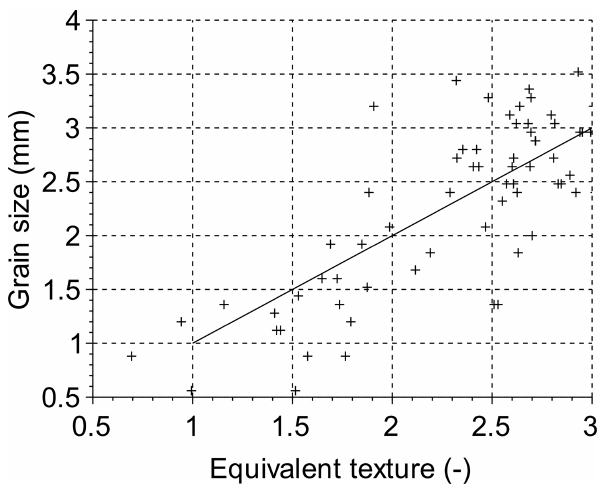
Figure 11. The validation dataset: the grain size from the texture analysis as compared to the hand-selected grain